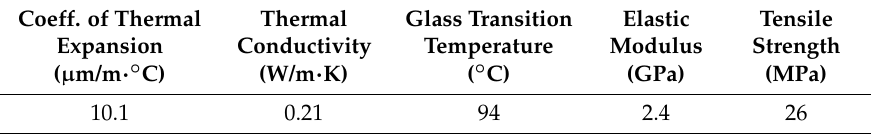
Table 2. Primary physical and mechanical properties of ABS at room temperature